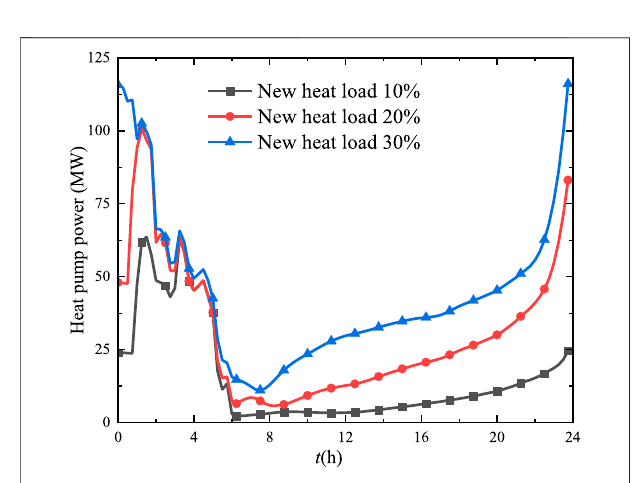
FIGURE 12 | Heat pump power under different new heat